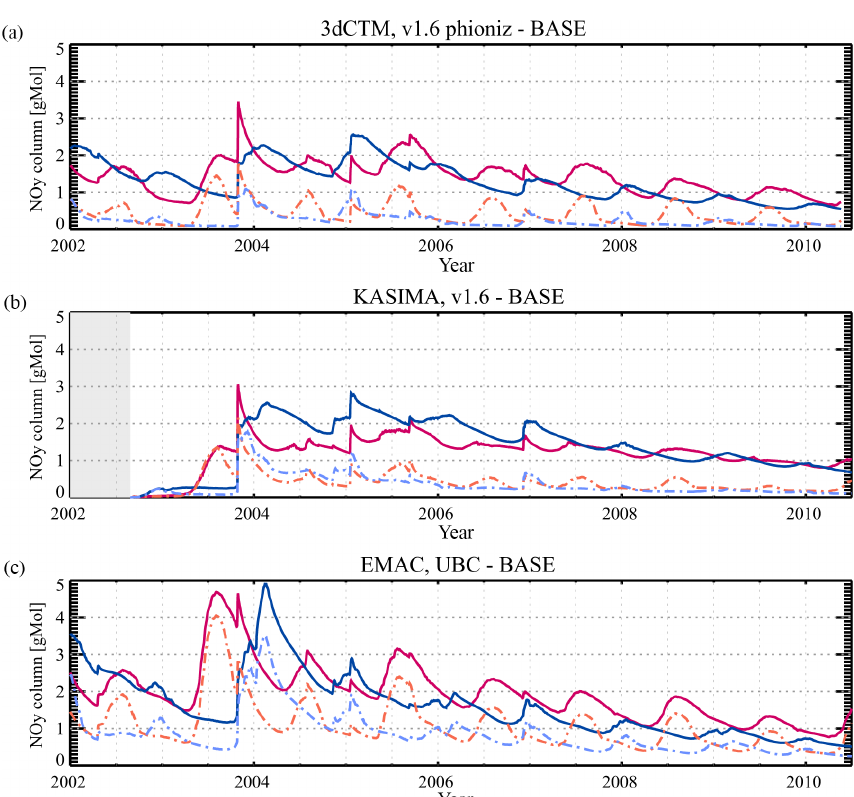
Figure 7. Total EPP NO y (Gmol) in the middle atmosphere as the difference between model runs with and without particle forcings. From top to bottom: 3dCTM, KASIMA, and EMAC. Red: hemispheric amount in the Southern Hemisphere; blue: hemispheric amount in the Northern Hemisphere; solid lines, dark colors: 200–0.01hPa (lower stratosphere to mesopause); dashed lines, light colors: 9–0.01hPa (mid-stratosphere to mesopause). The gray shading in the second panel denotes the period at the start where KASIMA results were not yet